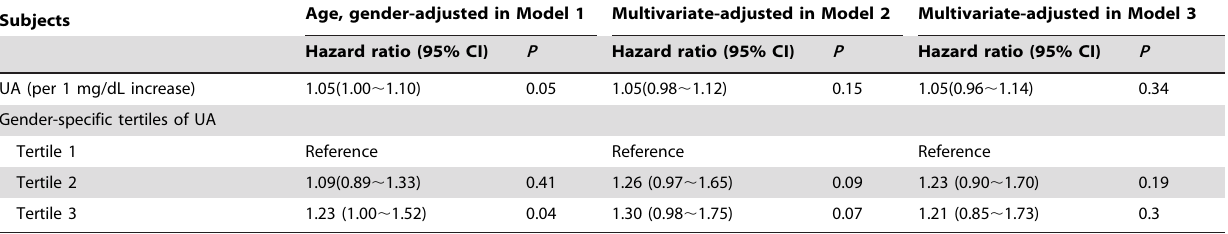
Table 2. The prognostic values of UA as continuous or categorical variable for all-cause mortality.